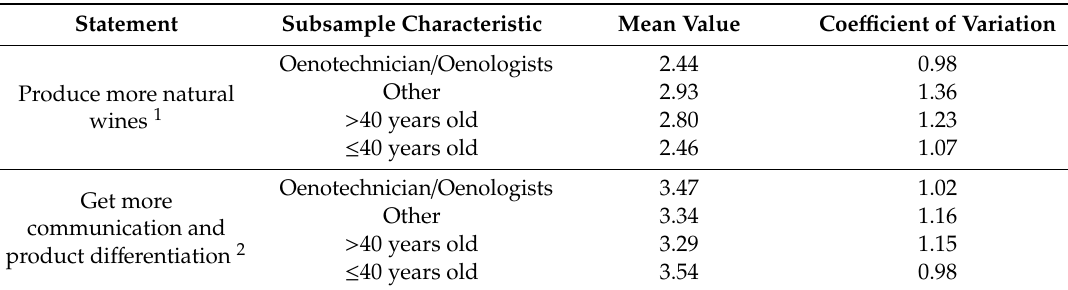
Table 4. Mean values and coefficients of variation related to the interactions between use of indigenous yeast for the two statements having the lowest (Produce more natural wines) and highest (Get more communication and product differentiation) mean values, and qualification (oenotechnicians / oenologists; other) and age ( > 40 years old; ≤ 40 years